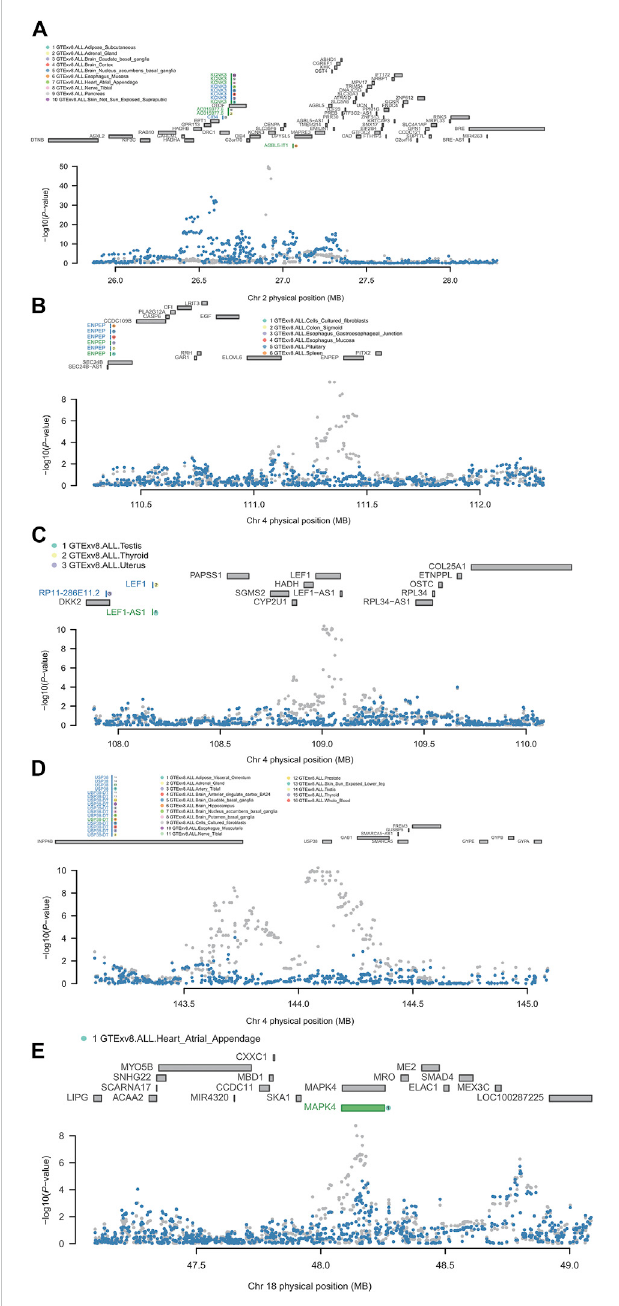
FIGURE 4 Regional association of TWAS hits. (A) Chromosome 2 regional association plot. (B) Chromosome4regional associationplot(part1). (C) Chromosome 4 regional association plot (part 2). (D) Chromosome 4 regional association plot (part 3). (E) Chromosome 18 regional association plot. The marginally associated TWAS genes are shown in blue, and the conditionally signi fi cant genes are shown in green. The bottom panel shows a regional Manhattan plot of the GWAS data before (gray) and after (blue) conditioning on the green genes ’ predicted